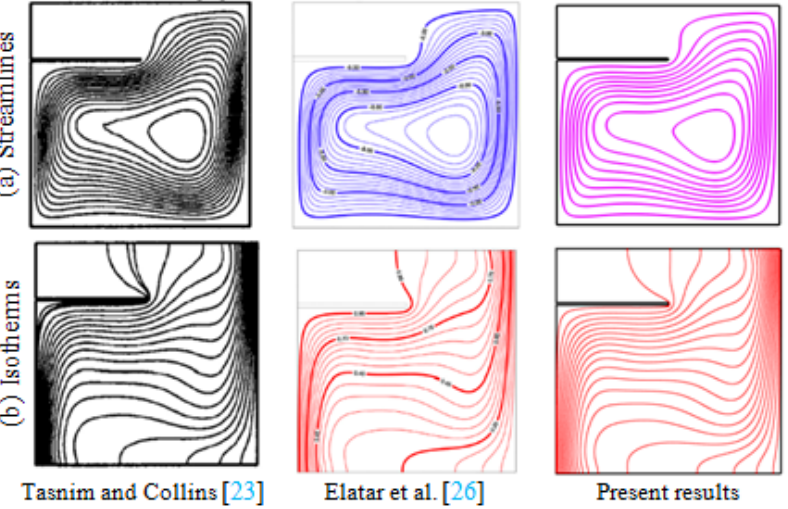
Figure 3. Comparison with streamlines and isotherms.